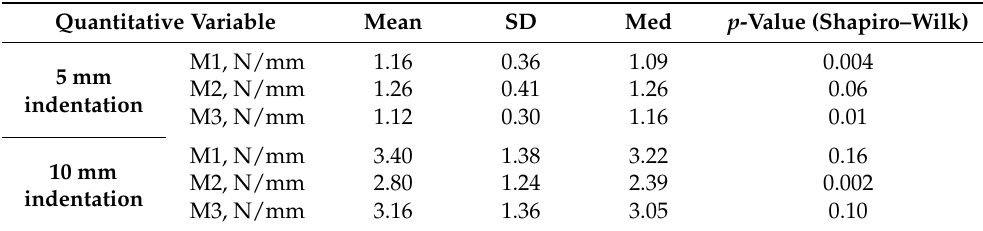
Table 2. Descriptive statistics and analysis of normal distribution for myofascial tissue stiff-